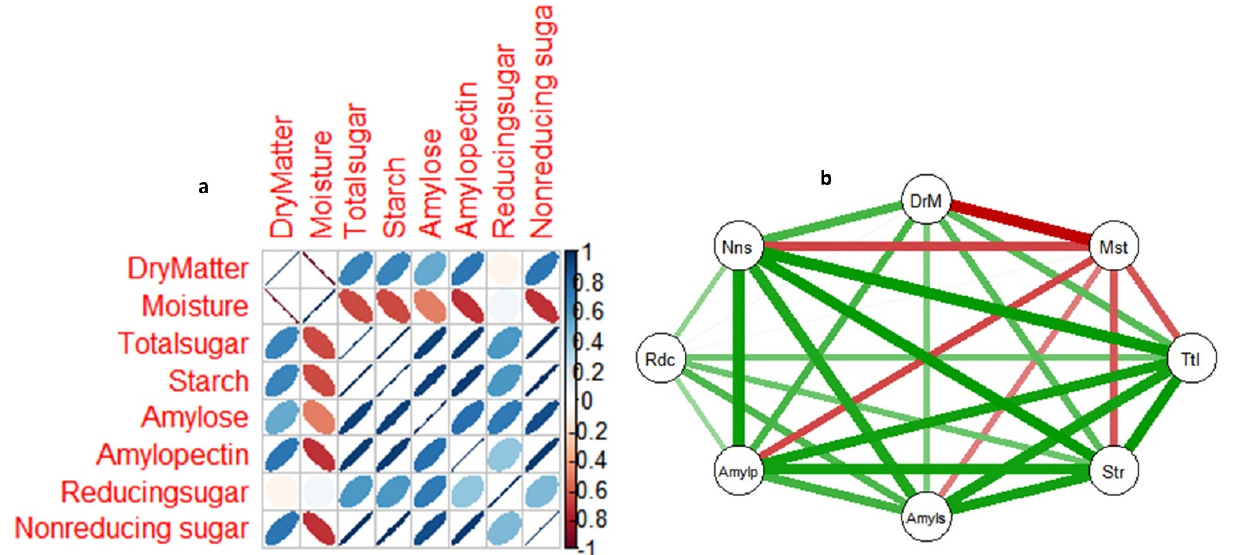
Figure 7. ( a , b ) Correlation matrix showing linear relationships between non-structural sugar parameters, dry matter, and moisture content in yam tubers from dormancy to sprouting. Both a and b are visualizing the same relationships in different formats. In both figures, color shades indicate the degree of relationship between two variables connected in the box or on edge at p = 0.05. In ( a ), variables connected by blue are positively correlated to each other, while those connected by red are negatively correlated. In ( b ), variables connected to each other at the edge by green-green lines are positively correlated, while those connected by red and green lines are negatively correlated .